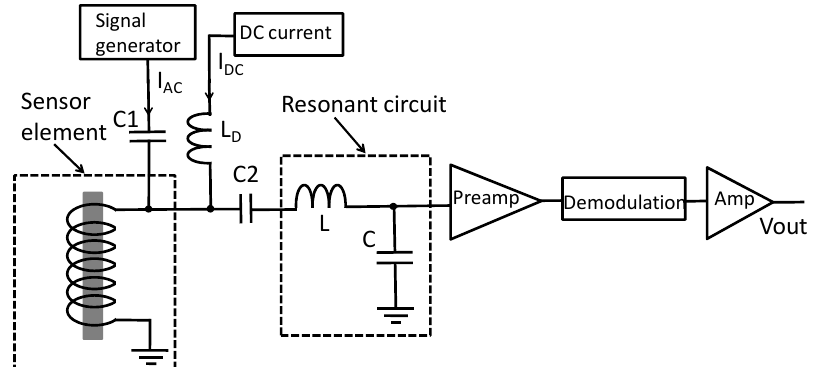
Figure 7. Block diagram of the driving circuit for the FeCoSiB amorphous wire magnetic sensor with the resonant circuit. The resonant circuit was composed of an inductor L and a capacitor C, which was used to increase the signal amplitude of the magnetic sensor.